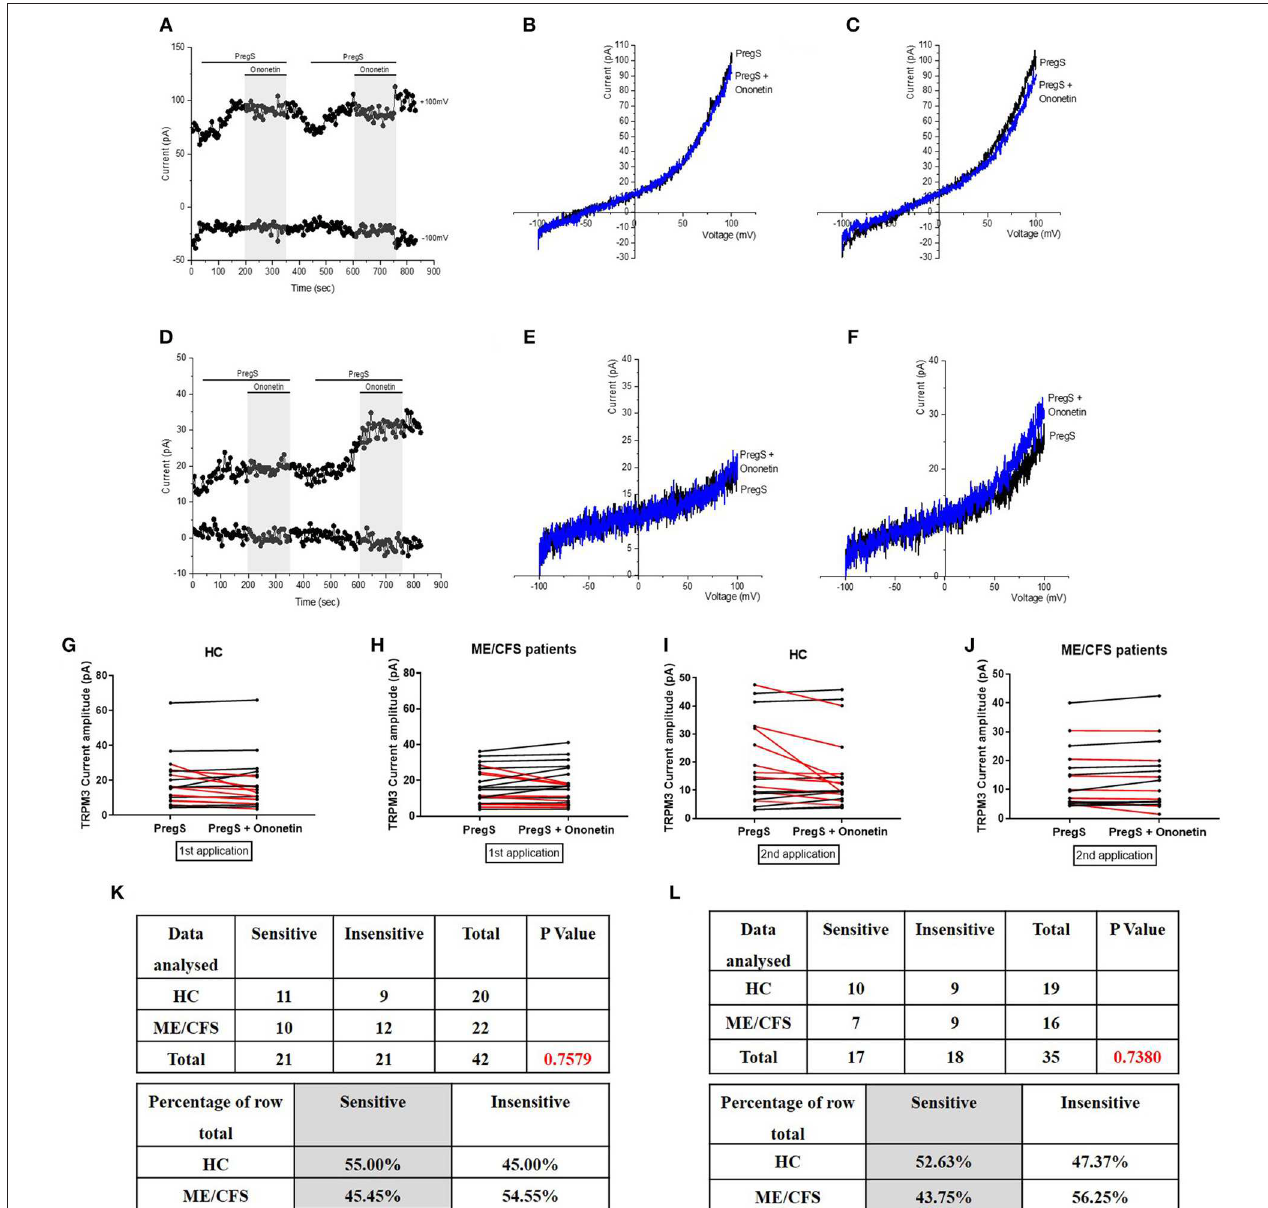
FIGURE 5 | Modulation of PregS- evoked currents with Ononetin after treatment with NTX. Data were obtained under whole-cell patch clamp conditions. (A) A representative time-series of current amplitude at + 100mV and − 100mV showing the effect of 10 µ M ononetin (gray) on ionic currents in the presence of 100 µ M PregS in IL-2 stimulated NK cells treated with 200 µ M NTX from HC. (B) I – V before and after the first application of ononetin in the presence of PregS in a cell as shown in (A). (C) I – V before and after the second application of ononetin in the presence of PregS in a cell as shown in (A). (D) A representative time-series of current amplitude at + 100mV and − 100mV showing the effect of 10 µ M ononetin (gray) on ionic currents in the presence of 100 µ M PregS in IL-2 stimulated NK cells treated with 200 µ M NTX ME/CFS patients. (E) I – V before and after the first application of ononetin in the presence of PregS in a cell as shown in (D) . (F) I – V before and after the second application of ononetin in the presence of PregS in a cell as shown in (D). (G,H) Scatter plots representing change of each current amplitude before and after the first application of ononetin in presence of PregS in all NK cells treated with 200 µ M NTX from HC and ME/CFS patients. Each cell represented as red lines had reduction in currents by ononetin. (I,J) Scatter plots representing change of each current amplitude before and after the second application of ononetin in presence of PregS in all NK cells treated with 200 µ M NTX from HC and ME/CFS patients. Each cell represented as red lines had reduction in currents by ononetin. (K) Table summarizing data for sensitive and insensitive cells treated with 200 µ M NTX to the first application of 10 µ M ononetin in presence of PregS in HC ( N = 8; n = 20) compared to ME/CFS patients ( N = 8; n = 22). (L) Table summarizing data for sensitive and insensitive cells treated with 200 µ M NTX to the second application of 10 µ M ononetin in presence of PregS in HC ( N = 8; n = 19) compared to ME/CFS patients ( N = 8; n = 16). Data are analyzed with Fisher’s exact test. ME/CFS, myalgic encephalomyelitis/chronic fatigue syndrome; HC, healthy controls; NK, natural killer; NTX, naltrexone hydrochloride; PregS, Pregnenolone sulfate; TRPM3, Transient Receptor Potential Melastatin